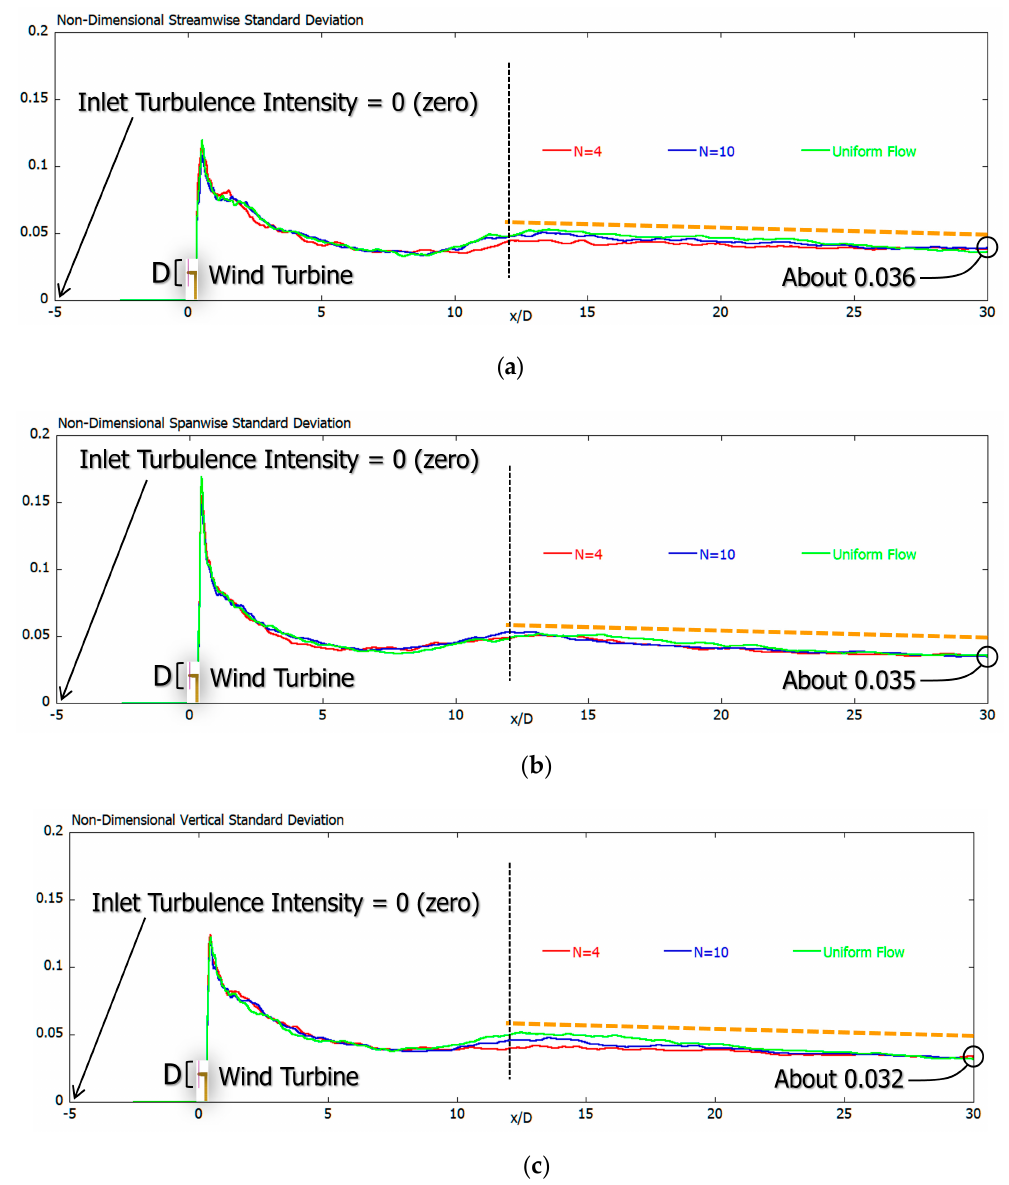
Figure 23. Comparison of nondimensional standard deviation distribution at the hub center of the wind-turbine: ( a ) streamwise, ( b ) spanwise, and ( c ) vertical directions.